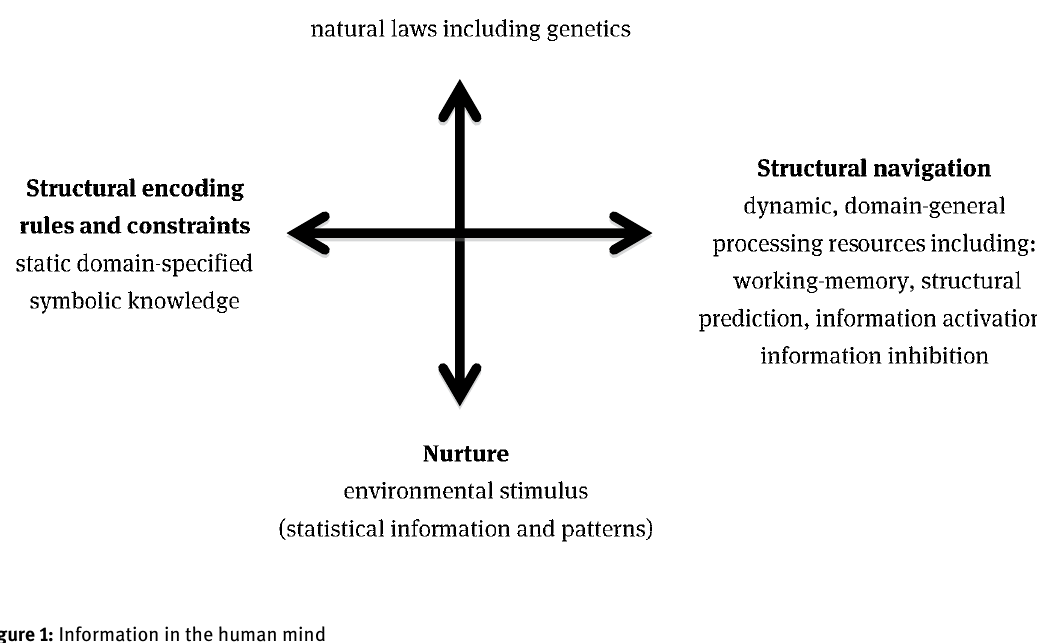
Figure 1: Information in the human